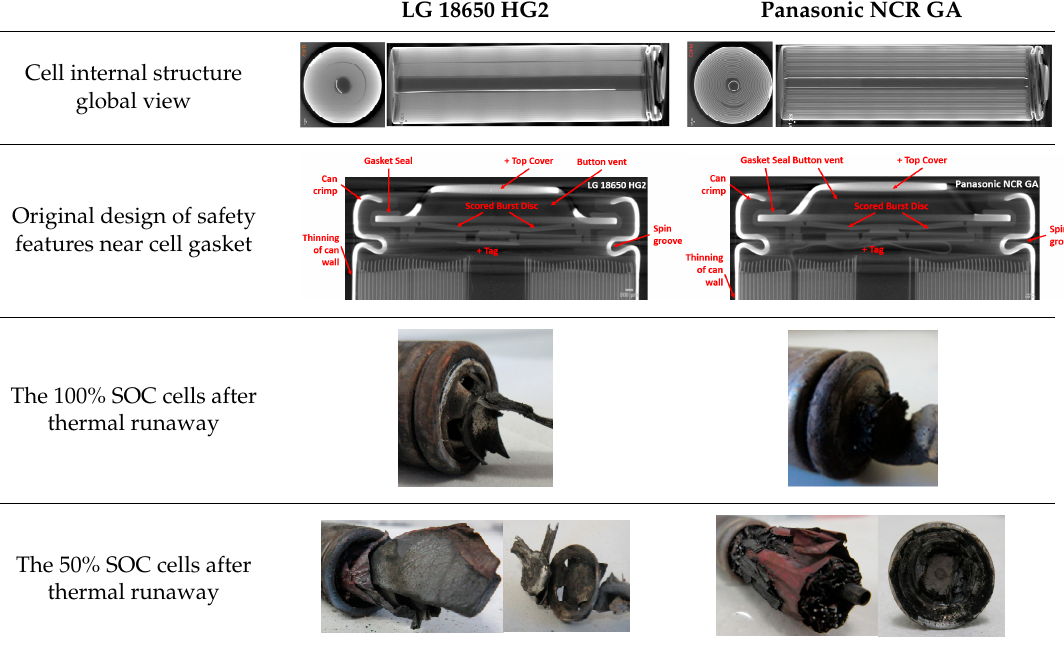
Figure 16. Cell voltage and vessel pressure (bar) versus temperature for LG HG2 100% SOC and 50% SOC. Table 2. The impact of safety features and SOC on venting and component ejection mechanisms, as seen through the pictures of LG HG2 and Panasonic NCR GA (50% and 100% SOC) after thermal runaway.